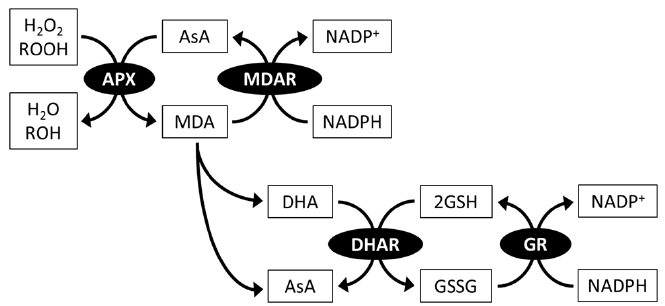
Figure 3. Ascorbate (AsA)-glutathione (GSH) cycle. All or some of genes and activities of AsA- GSH components have been identified in all microalgal divisions. APX, ascorbate peroxidase; ROOH, organic hydroperoxides; MDA, monodehydroascorbate; MDAR, MDA reductase; DHA, dehydroascorbate; DHAR, DHA reductase; GSSG, oxidized glutathione; GR, glutathione reductase. During the APX reaction, APX simultaneously produces monodehydroascorbate (MDA), which is a univalent oxidant of AsA. MDA is then spontaneously disproportion- ated to AsA and dehydroascorbate (DHA), a divalent oxidant of AsA. MDA and DHA are reduced back to AsA by MDA reductase (MDAR) using NADPH as an electron donor, and DHA reductase (DHAR) using glutathione (GSH) as an electron donor, respectively. The resulting oxidized form of glutathione (GSSG) is reduced back to GSH by glutathione reduc- tase (GR) using NADPH as an electron donor. This AsA-regenerating system is termed the AsA-GSH cycle and is essential for maintaining AsA redox homeostasis (Figure 3) [84,86]. The number and localization (including predictions) of some microalgae AsA-GSH cycle enzymes have been documented. C. reinhardtii contains three APX isoforms; APX1 and APX2 were predicted to be dual-targeted in chloroplasts and mitochondria, and APX4 in chloroplasts [87]. Single MDAR and DHAR enzymes are present in C. reinhardtii , and they are probably located in the cytosol [88,89]. C. reinhardtii GRs are composed of two isoforms [90]. E. gracilis contains APX, MDAR, DHAR, and GR enzymes as a single